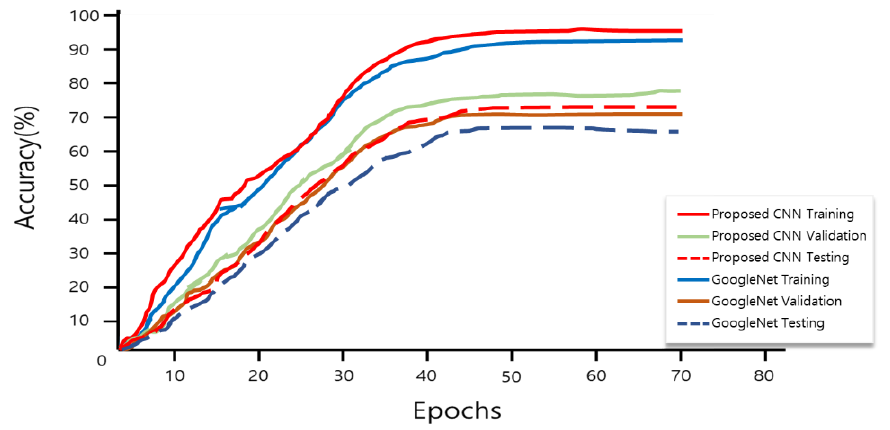
Figure 19. Roof Learning Proposed CNN, GoogleNet Accuracy Results. Table 5. Learning Training, Validation, Testing Accuracy result.